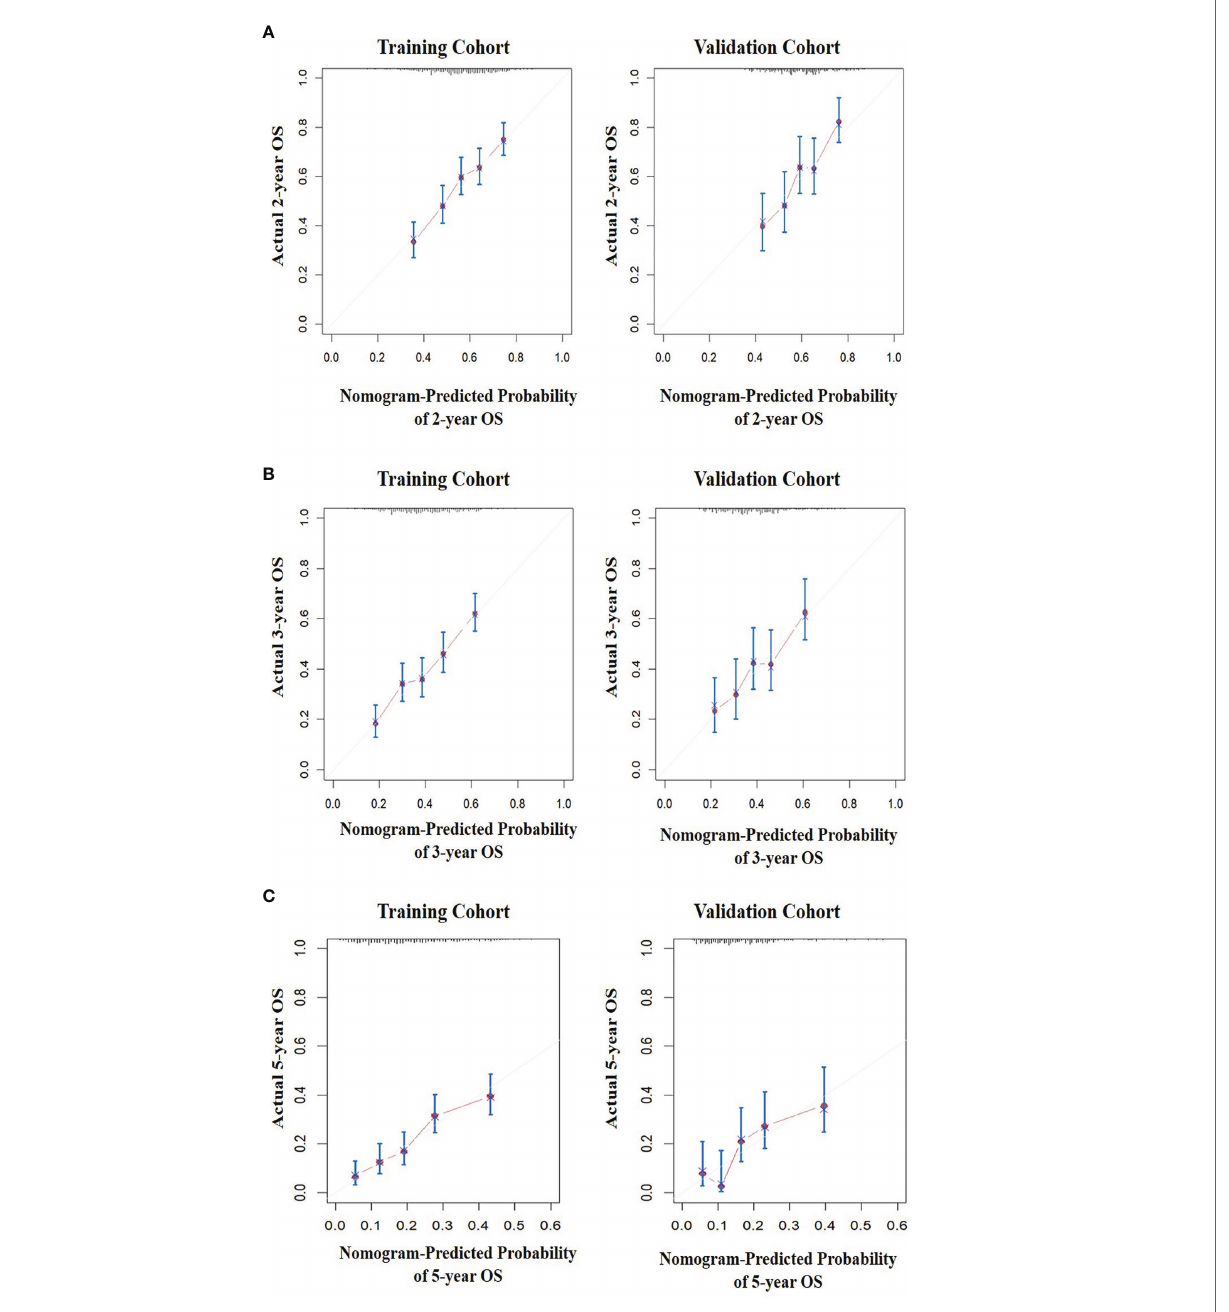
FIGURE 3 | The calibration curves for predicting the survival of patients. (A) The 2-year OS prediction in the training and validation cohort after diagnosis. (B) The 3- year OS prediction in the training and validation cohort after diagnosis. (C) The 5-year overall survival prediction in the training and validation cohort after